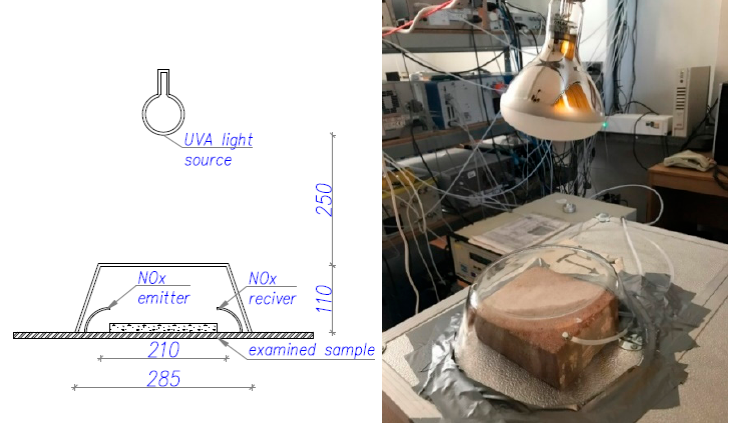
Figure 3. Test for air purification performance of photocatalytic concrete pavement blocks.